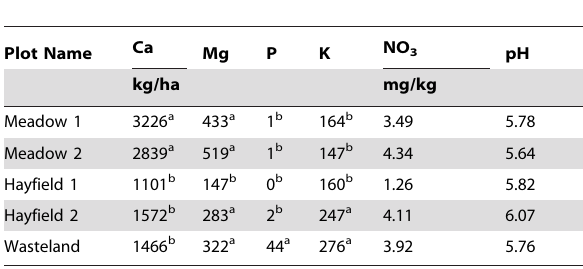
Table 1. Soil nutrients and pH in five field plots prior to the